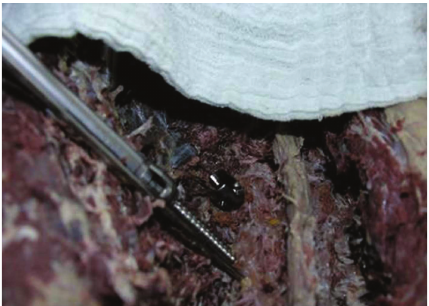
Figure 3: Starting insertion of the screw parallel to the 10-degree